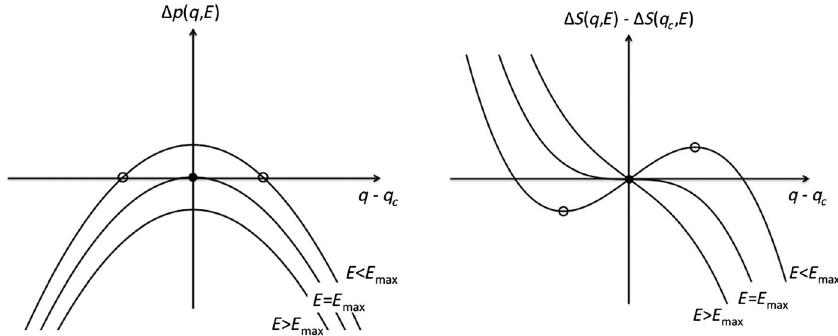
FIG. 8. Behavior of Δ p and Δ S for E ≈ E These coalesce into a single point of tangency at E ¼ E